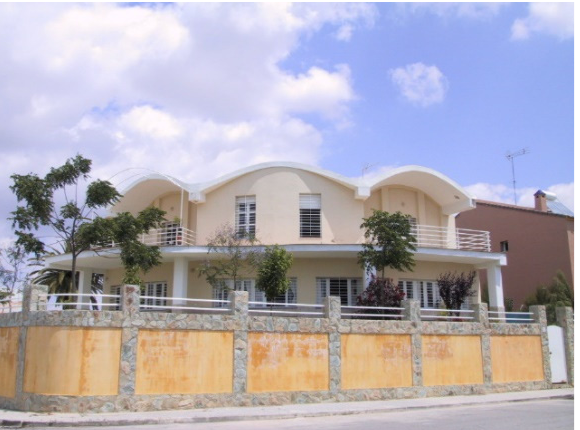
occasional steel reinforcement.